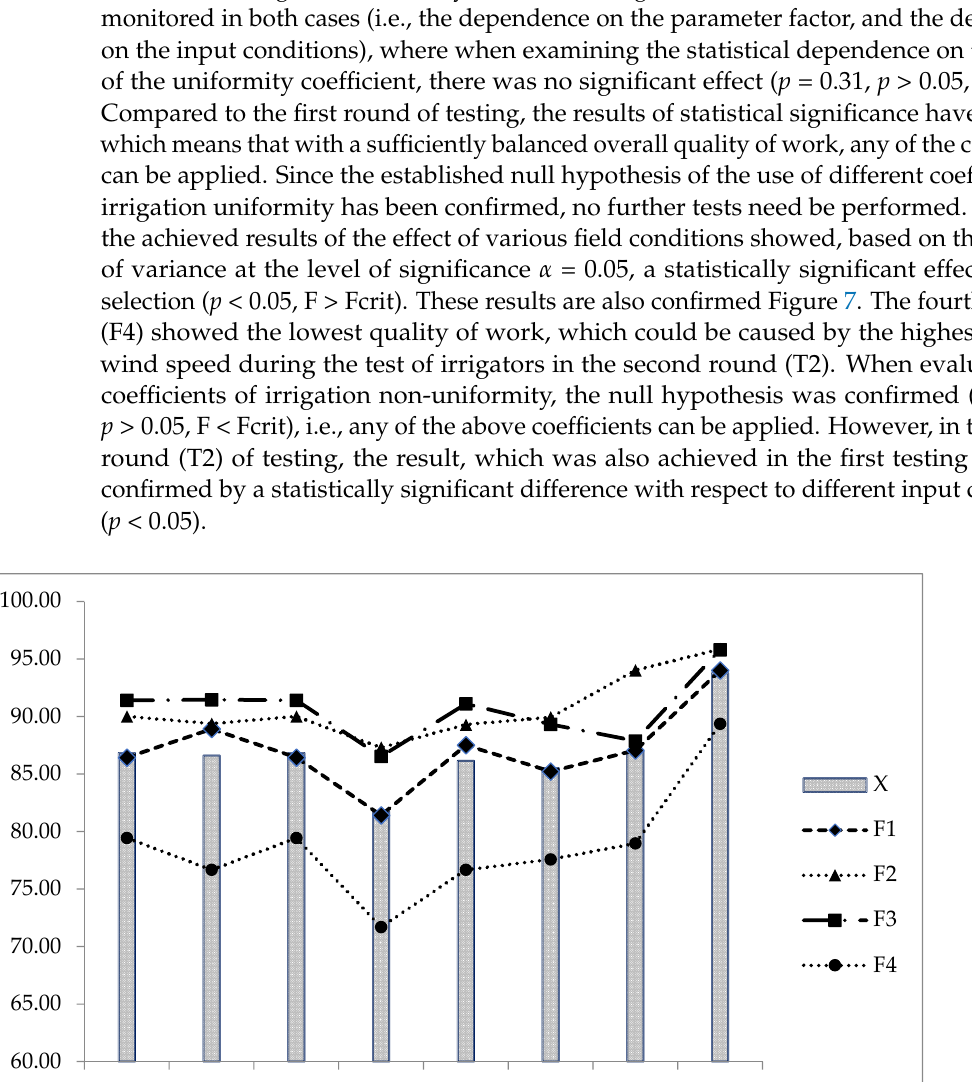
Figure 7. The results of different coefficients of non-uniformity for all experimental fields, for T2 where: a—coefficient of non-uniformity according to Oehler, Cv—coefficient of variation, Ef—degree of non-uniformity according to Hofmeister, γ —coefficient of non-uniformity according to Voigt. Based on the results obtained in the second round (T2) of testing, a third round (T3, in Table 2) was deployed, where a minimal effect of weather conditions was observed. A graphical representation of the results, which presents the results obtained in all rounds of testing for irrigators (T1, T2 and T3) under field conditions (F1 and F4), is shown in Figure 8 (irrigation uniformity) and Figure 9 (irrigation non-uniformity). Coefficients of irrigation uniformity ranged from 75.97 to 92.16% (only for the third round of testing).